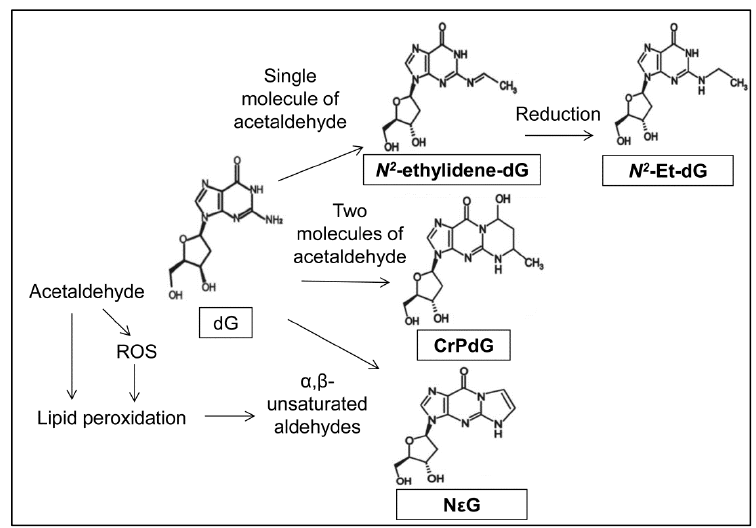
Figure 3. Formation of acetaldehyde-mediated DNA adducts. A single molecule of acetaldehyde reacts with deoxyguanosine (dG) to generate N 2 -ethylidene-2 (cid:48) -deoxyguanosine ( N 2 -ethylidene-dG), which can be reduced to the stable adducts, N 2 -ethyl-2 (cid:48) -deoxyguanosine ( N 2 -Et-dG). α - S - and α - R -methyl- γ -hydroxy-1, N 2 -propano-2 (cid:48) -deoxyguanosine (CrPdG) is derived from dG and two molecules of acetaldehyde. N 2 -etheno-2 (cid:48) -deoxyguanosine (N ε G) is formed from dG and α , β -unsaturated aldehydes during lipid peroxidation, which is mediated by acetaldehyde or reactive oxygen species